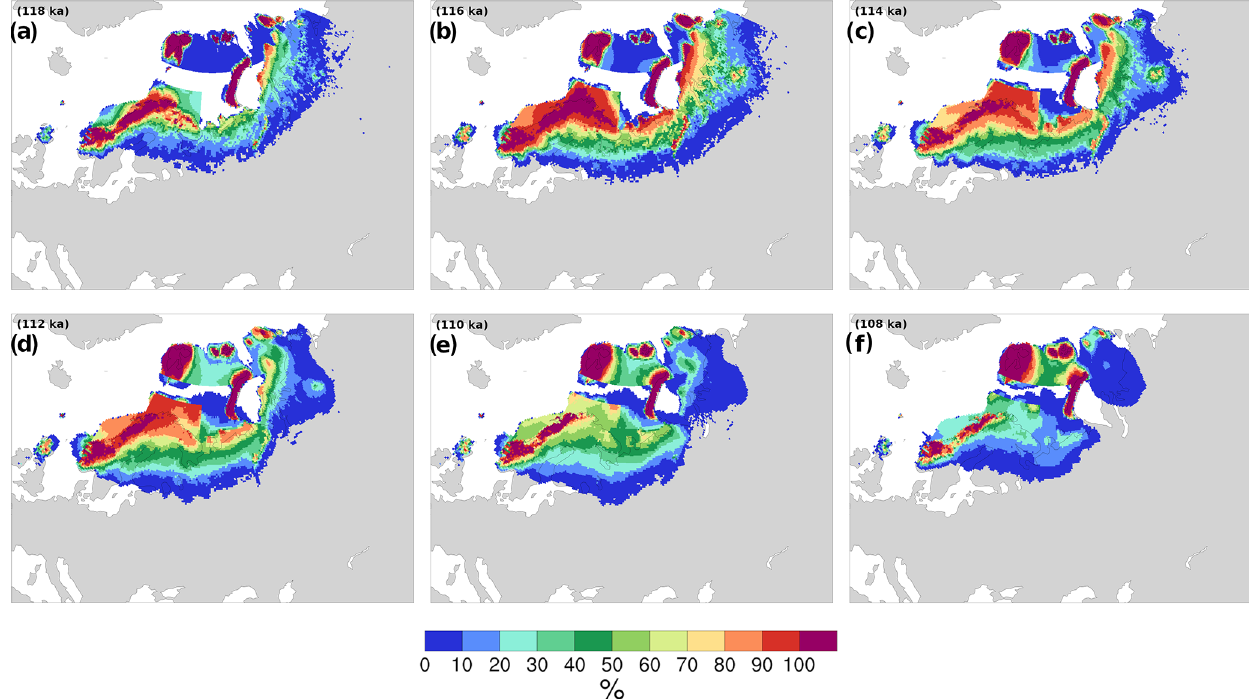
Figure 7. EA ice extent ensemble probability distribution at (a) 118ka, (b) 116ka, (c) 114ka, (d) 112ka, (e) 110ka, and (f) 108ka. The 118 and 116ka distributions are included to provide the history before the peak and are not discussed.